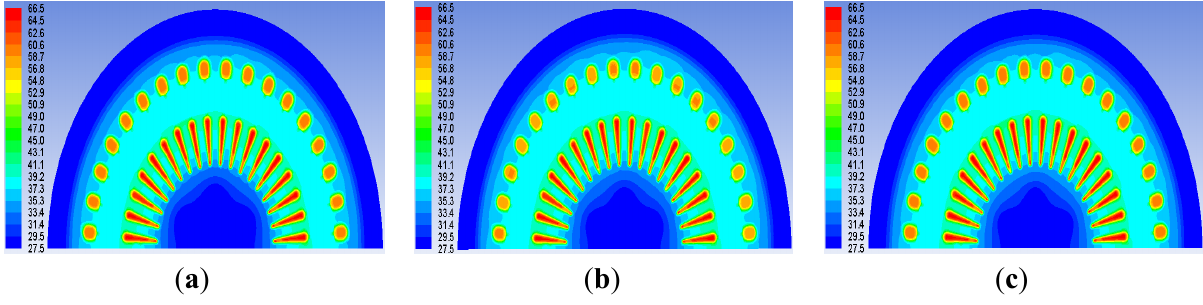
Figure 22. Thermal field distribution of three cross-sections: ( a ) the water inlet side; ( b ) the middle cross-section; and ( c ) the water outlet